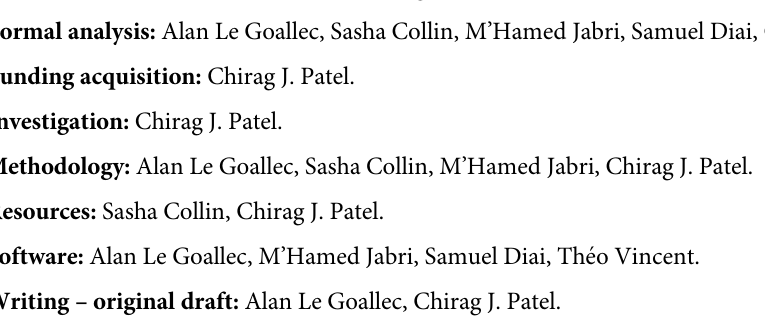
S23 Table. Hyperparameter space for scalar features-based models Bayesian optimization. S24 Table. Nested Cross-Validation pipeline. S25 Table. Hyperparameters tuning upstream of the cross-validation for images-based models. S26 Table. Outer Cross-Validation with inner split pipeline. The values displayed are vali- dation RMSE values. Lower values are associated with better hyperparameter tuning. When two values are displayed (value1/value2), the second value corresponds to the training RMSE. The architecture used was InceptionV3, with an initial learning rate of 0.001. The model was trained on the data folds 2–9, and validated on the data fold #0. The data fold #1 was set aside as the testing set and was not